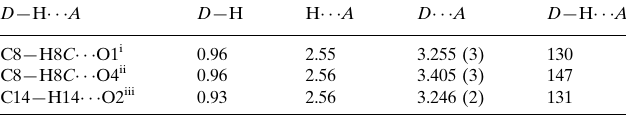
Hydrogen-bond geometry (A˚ , (cid:1)